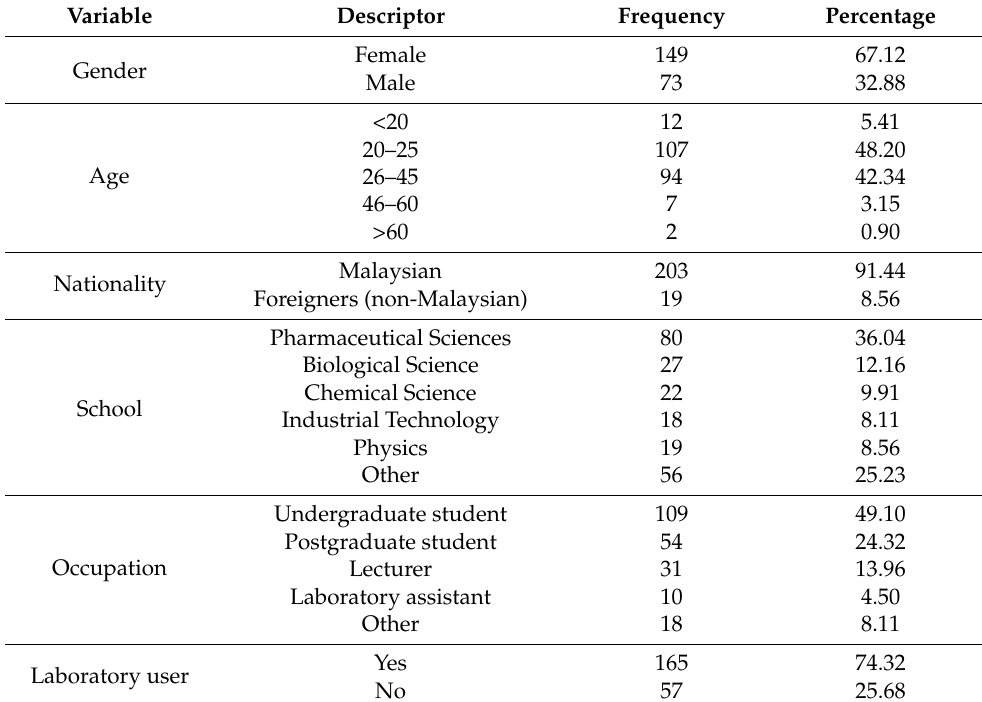
Table 1. The demographic distribution of the survey